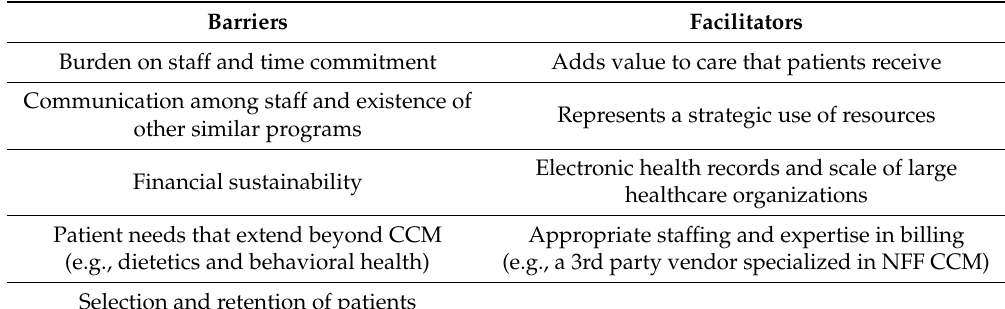
Table 2. Themes related to barriers and facilitators identified by